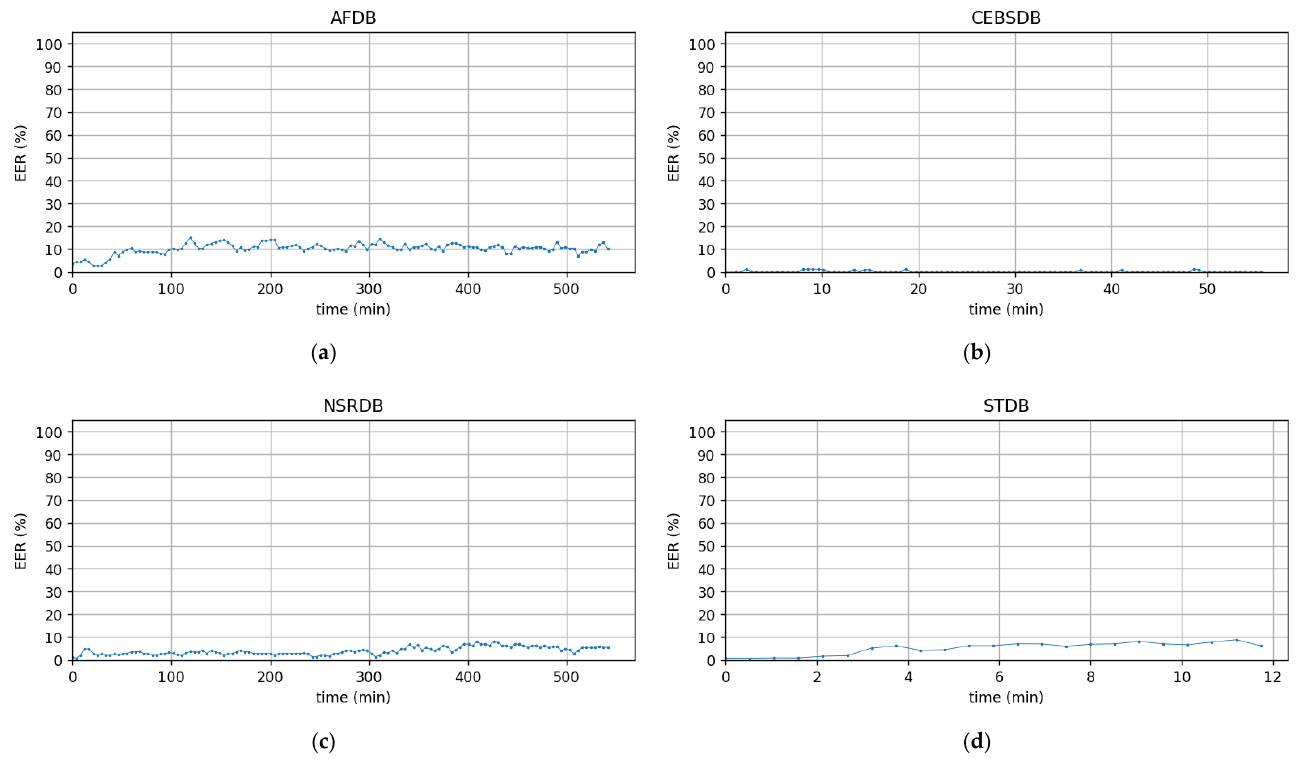
Figure A5. TPR of individual verification is plotted against time separation when FPR is at 1%, 5%, and 10% for: ( a ) AFDB, ( b ) CEBSDB, ( c) NSRDB, ( d ) STDB.